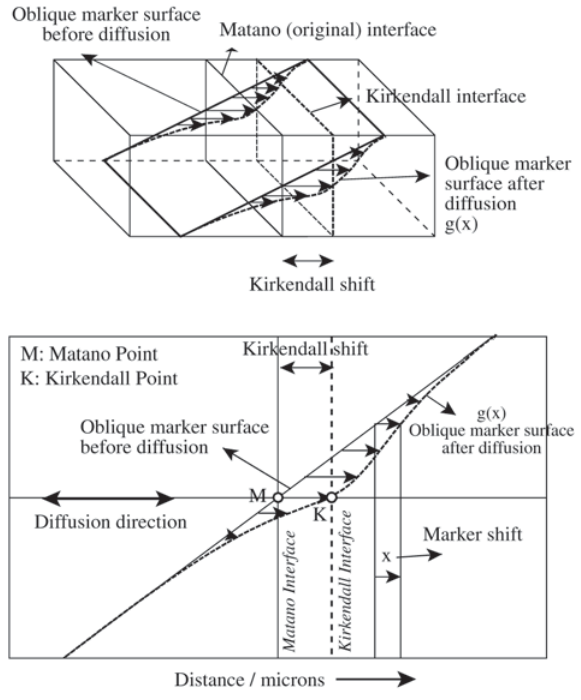
Figure 5. Oblique marker plane for the determination of lattice velocities for the entire diffusion zone before and after the interdiffusion